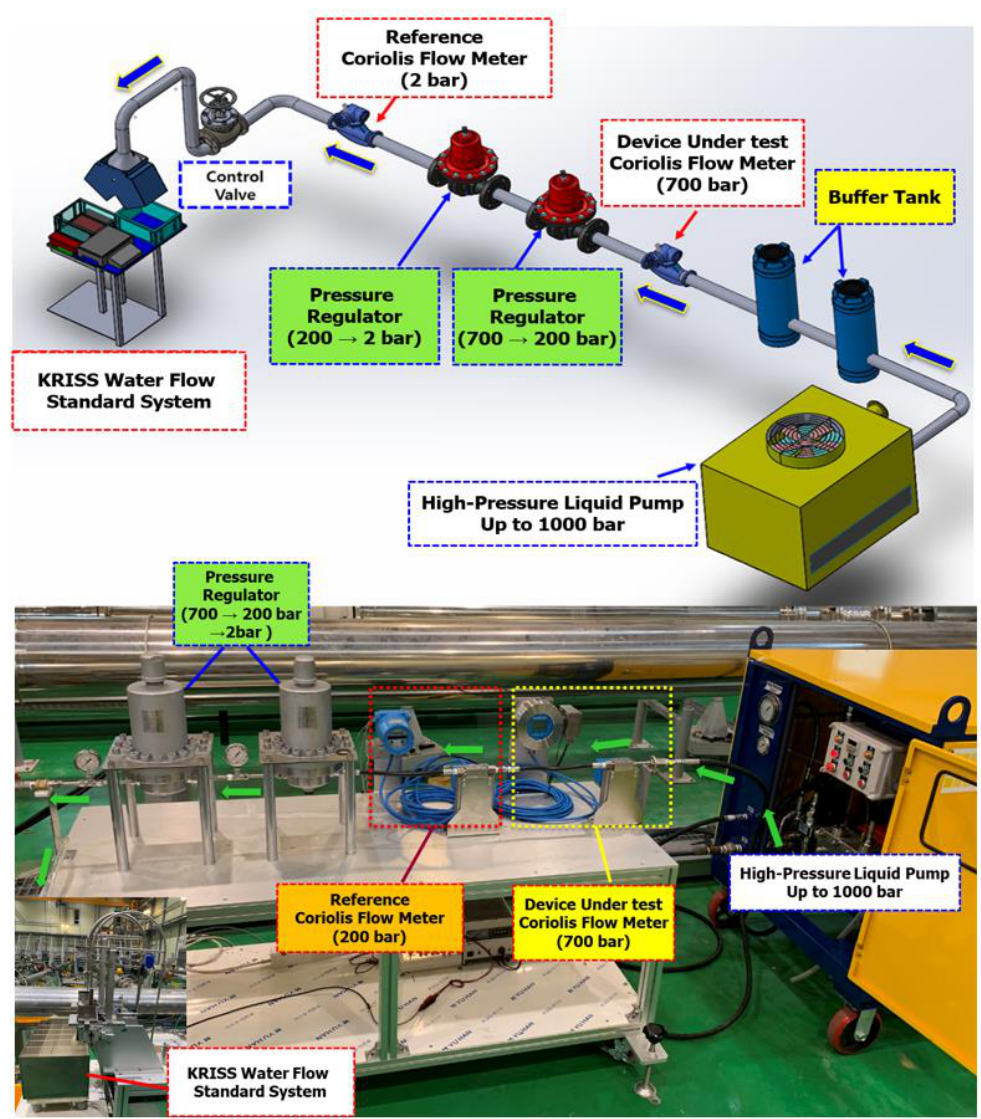
Figure 5. High-Pressure Water Flow Test Facility of KRISS.